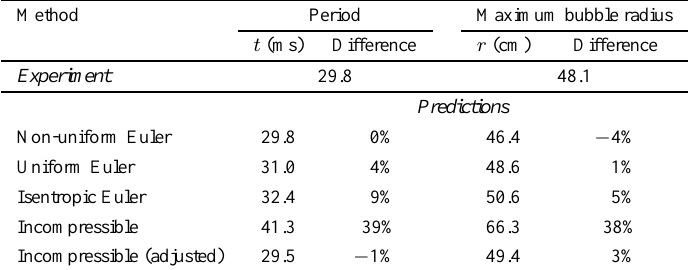
Predictions and experiment for the 91.4 m, 300 g case